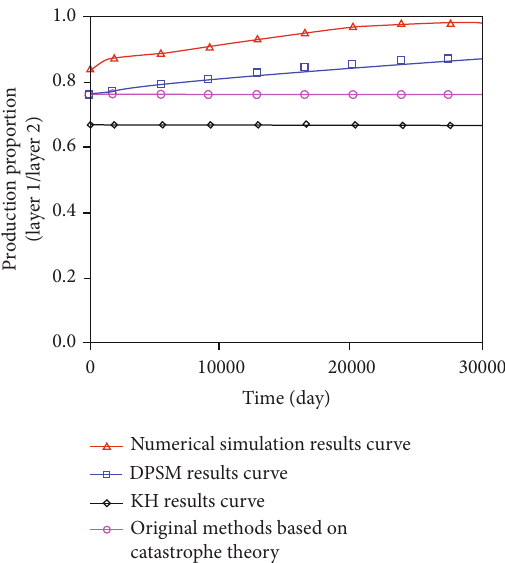
Figure 8: Comparison of results between the DPSM, KH method, and numerical